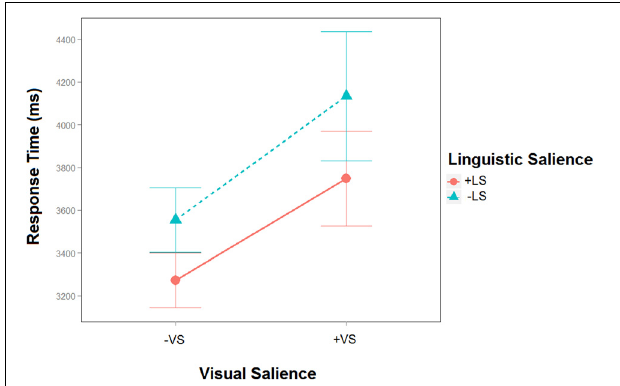
FIGURE 2 | Response times of the Linguistic ( + LS; − LS) and Visual ( + VS; − VS) salience in the last sentence. RTs are significantly faster in the + LS − VS condition compared to the other three conditions whereas RTs are slowest in the − LS + VS compared to all other